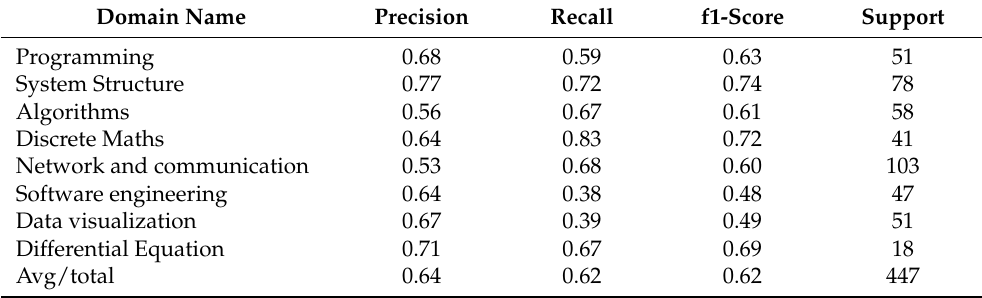
Table 4. Training and test with